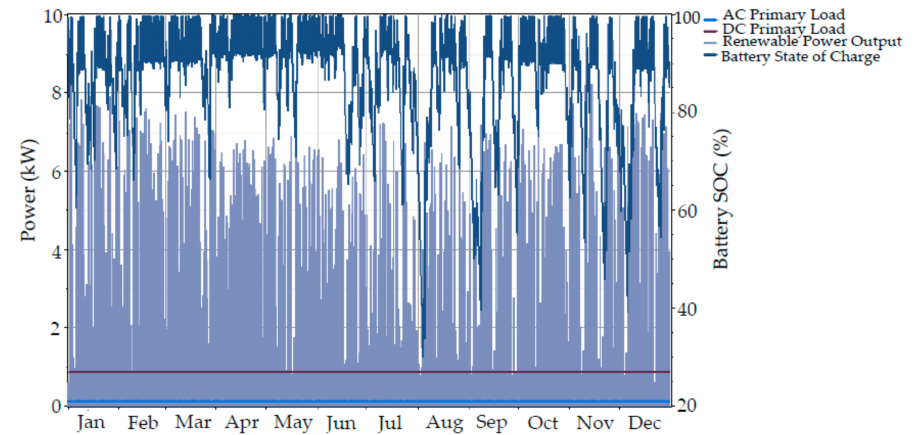
Figure 14. The average hourly power contribution of the PV array and battery bank.